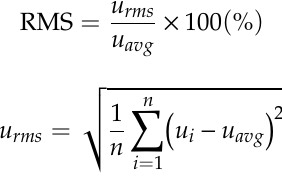
Figure 12. RMS error results by cases listed in Table 5. Base 1